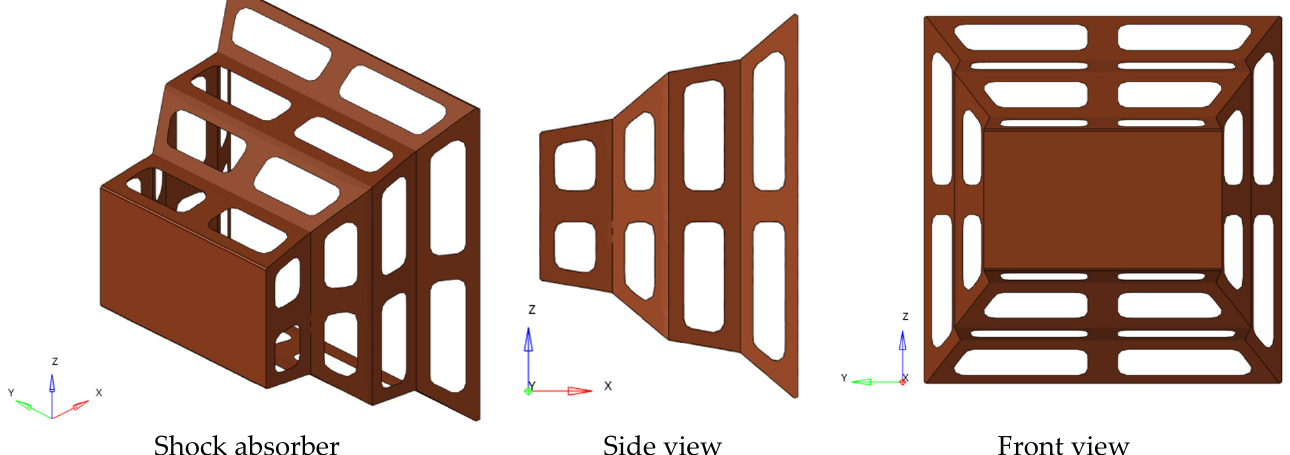
Figure 4. The shock absorber system .